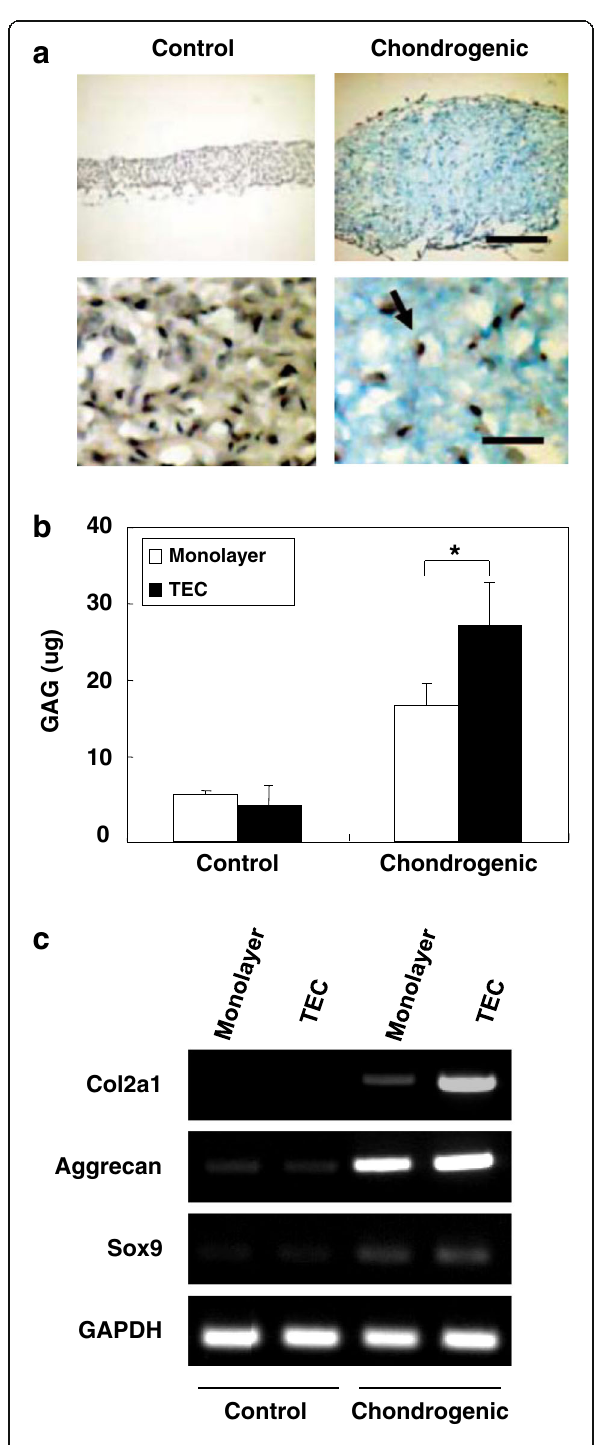
Fig. 2 Chondrogenic differentiation capacity of TECs. a Alcian blue staining of a TEC in control medium or in chondrogenic differentiation medium. Bar = 300 um (upper). Bar = 50 um (lower). Arrow showing the cell nuclei are in lacuna. b The quantification of GAG content of synovial MSC monolayer culture or TEC in the control medium or in the chondrogenic medium. GAG synthesis is significantly higher in the TEC exposed to the chondrogenic medium ( N = 8). * ; p < 0.05. c Semiquantitative reverse transcription – polymerase chain reaction (RT-PCR) analysis of synovial MSC monolayer culture or TEC for chondrogenic marker genes, type II collagen (Col2a1), aggrecan, SOX9, and GAPDH. Quoted and modified from Ando et al. , Tissue Eng Part A